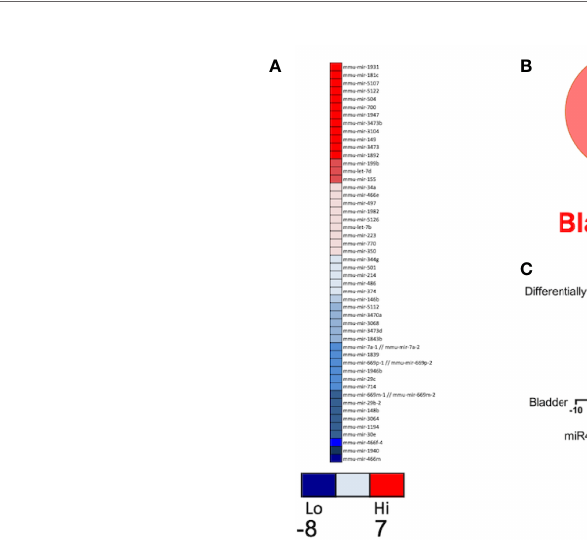
FIGURE 2 | Differentially expressed miRs (DEMs) between the bladder and iliac lymph nodes in a mouse model of experimental IC. (A) Top DEMs diverge between tissue types and controls. (B) . Urinary bladder and iliac lymph nodes DEMs share similar distribution with 50 overlapping miRs. (C) Differential expression of miRs in urinary bladder versus iliac lymph nodes. Normalized in Log2 scale FC.